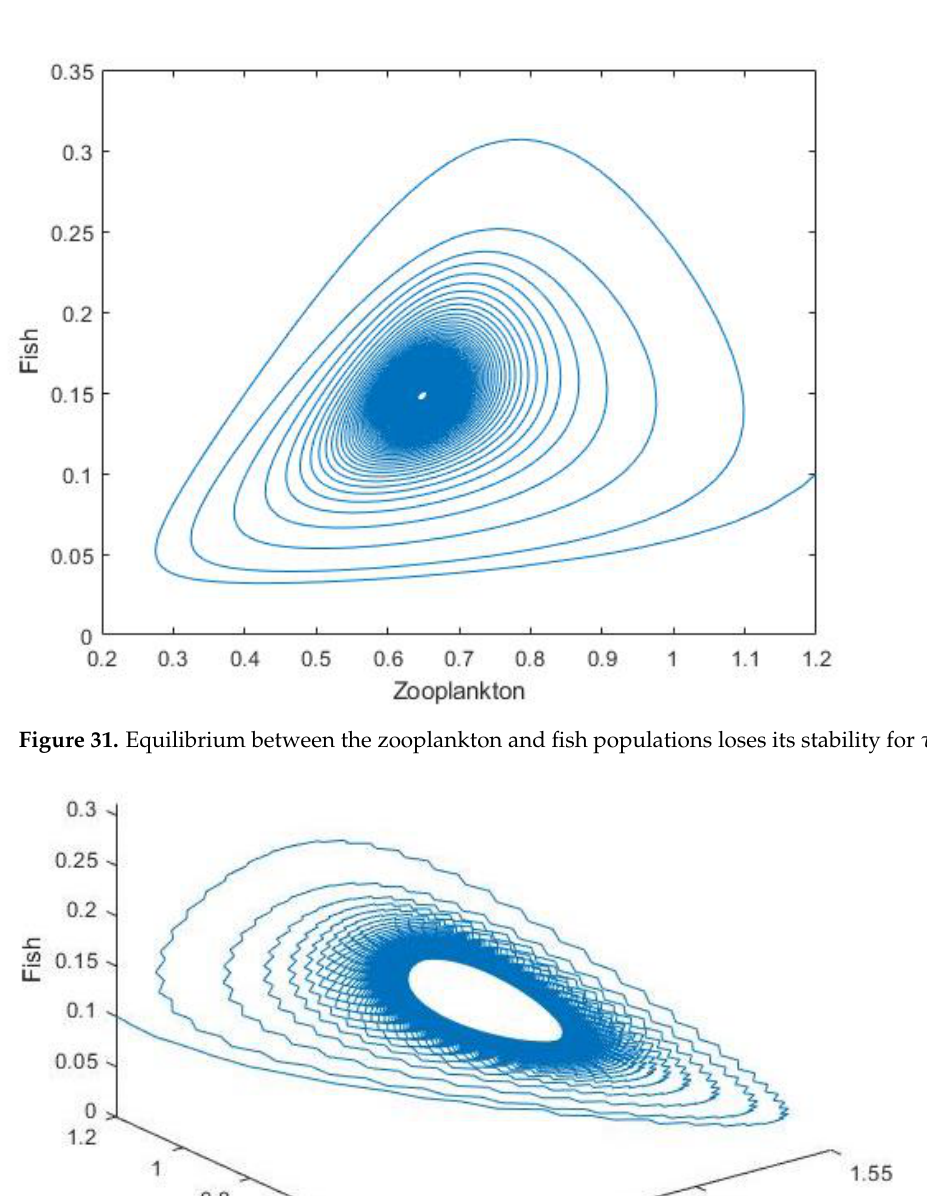
Figure 32. Equilibrium of all populations loses its stability for τ = τ −